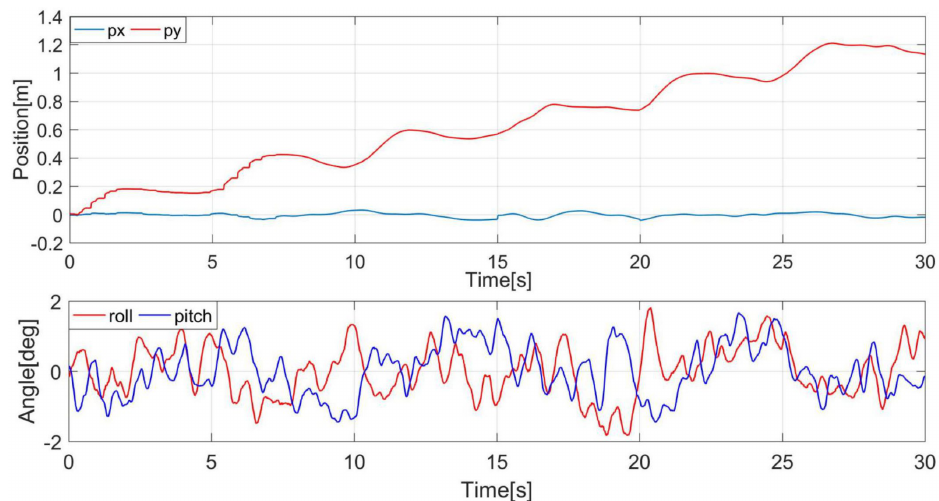
Figure 10. Experimental result of positioning by 0.2 m.